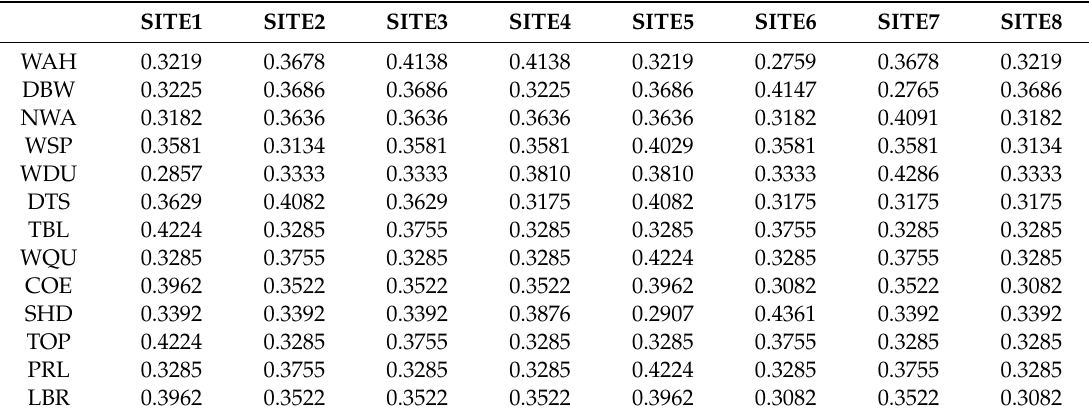
Table 7. Normalized matrix.